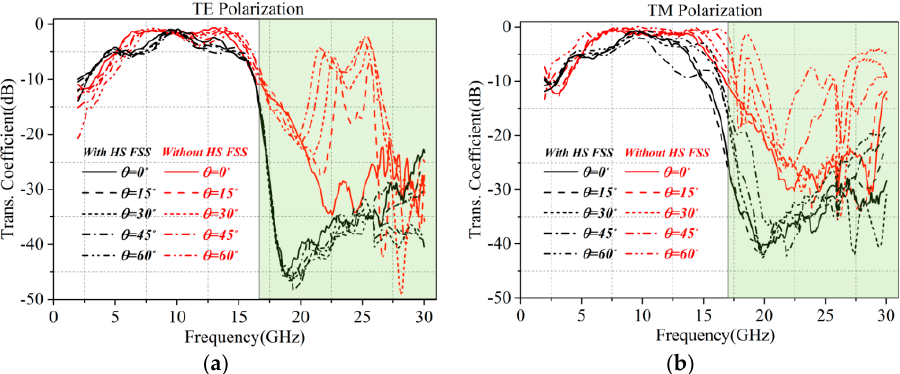
Figure 14. Comparison of the measured transmission coefficients between the non-resonant FSS with HS-FSMSE and without HS-FSMSE for oblique incidence angles for the ( a ) TE polarization and ( b ) TM polarization (The green shadow represents suppressed harmonic transmission bands).